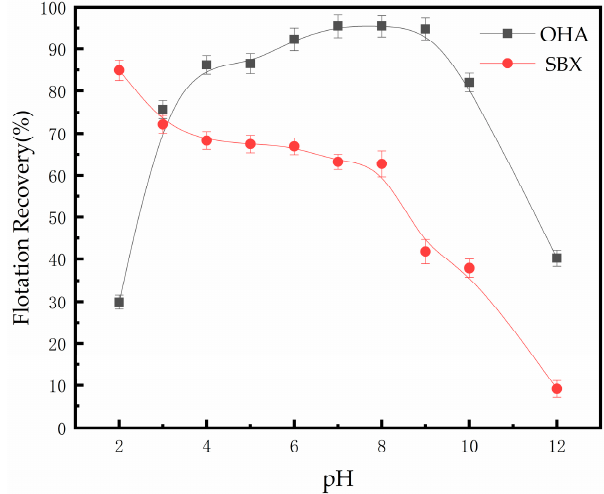
Figure 2. Effect of pulp pH values on the flotation of pyrrhotite (ET = 24 h).